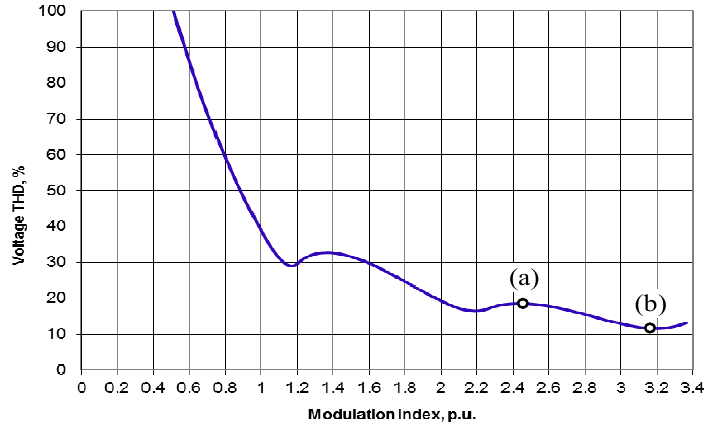
Figure 10. Minimal voltage THD vs. modulation index for n = 3.